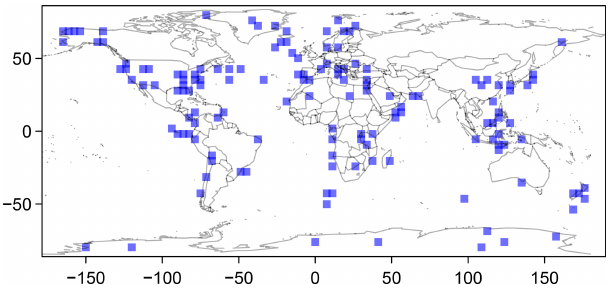
Figure 10. Map of the locations for the ensemble of surrogate prox-